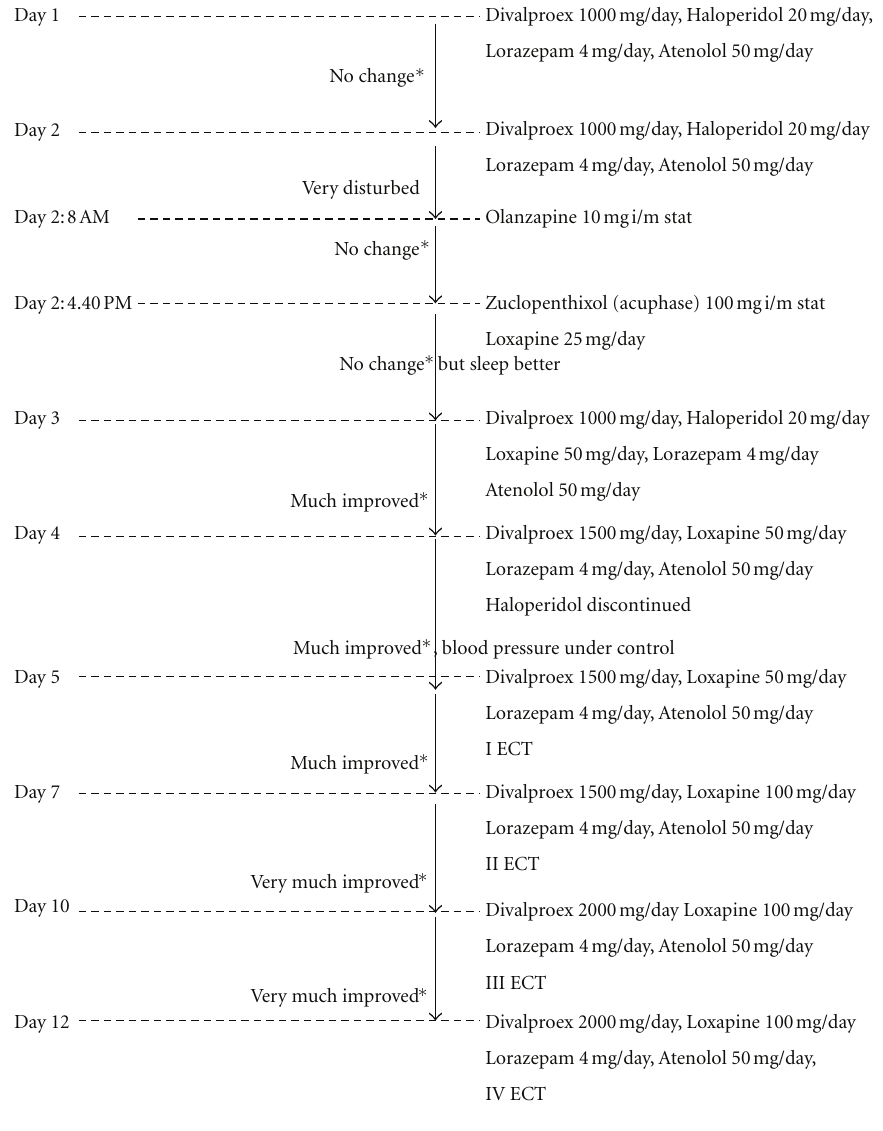
Figure 1: Flowchart depicting the treatment details in our